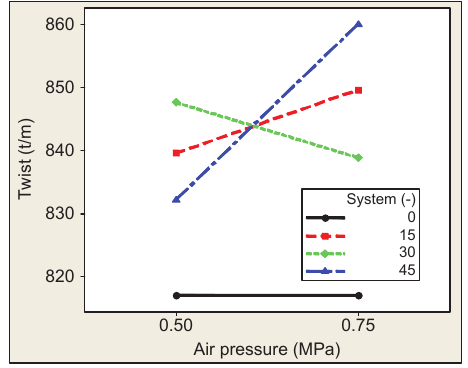
Figure 7 Twist values of the yarns.